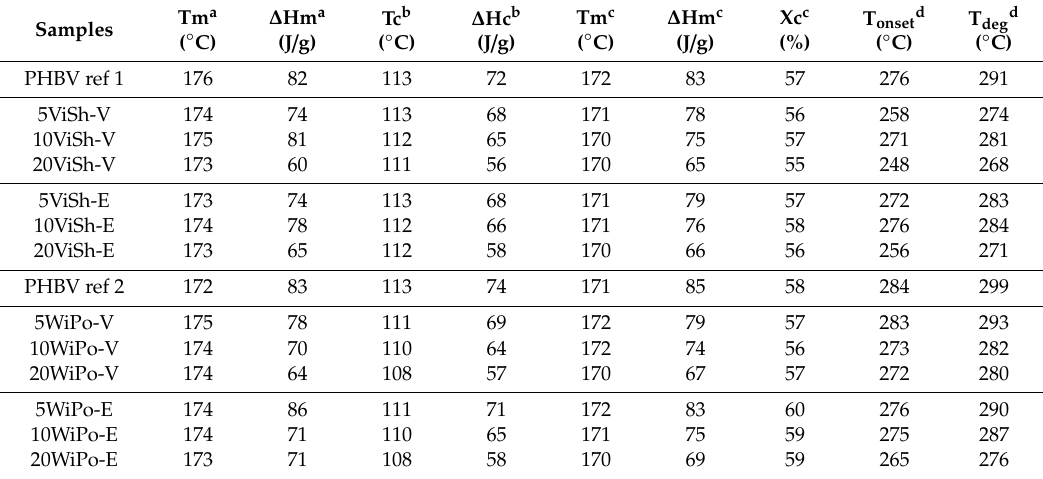
Table 5. Thermal properties of the ViSh- and WiPo-based composite